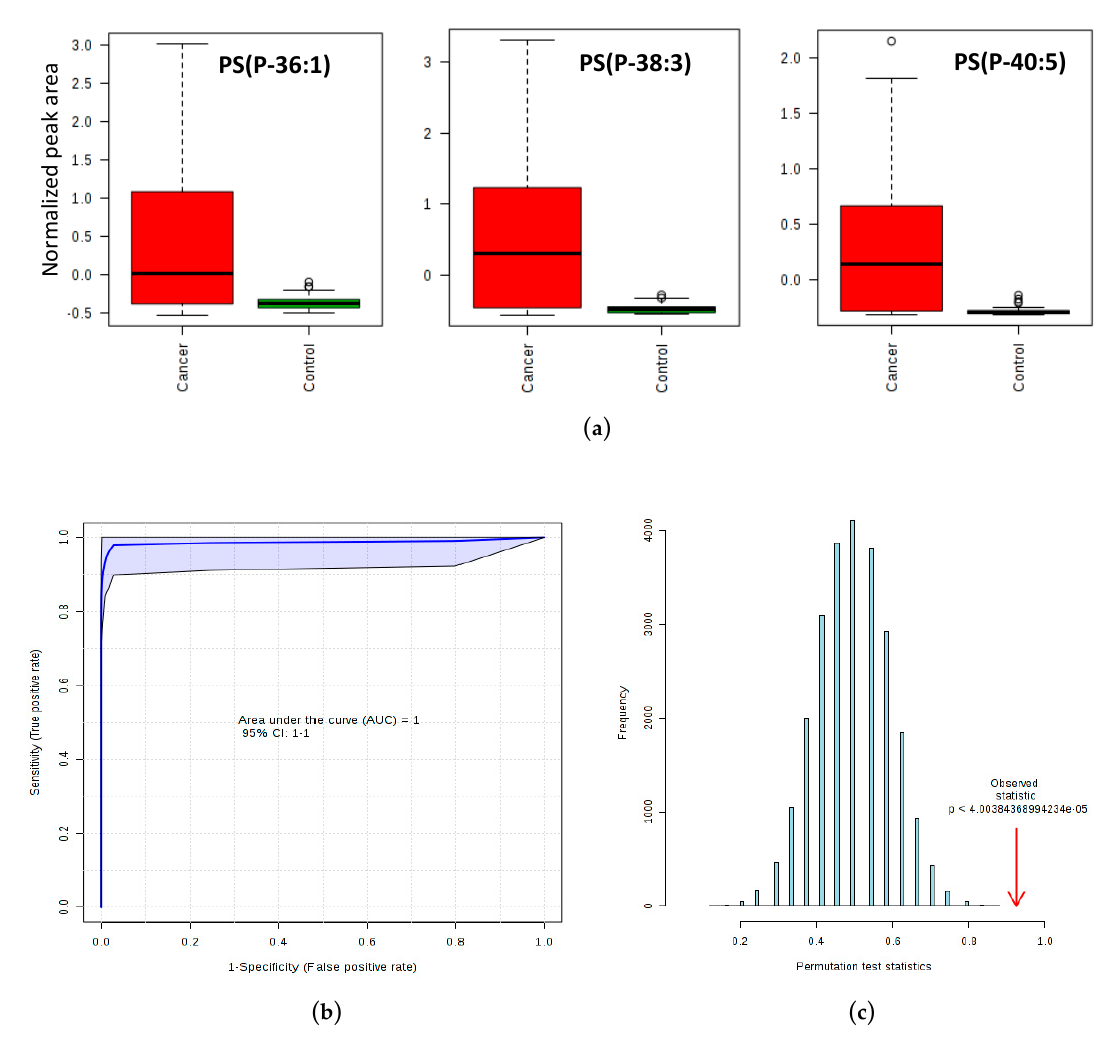
Figure 3. Plasmalogens elected for the predictive support vector machine (SVM) model. ( a ) Boxplots of the phosphatidylserine plasmalogens PS (P-36:1), PS (P-38:3) and PS (P-40:5). Data are represented as box plots with the median and 25th and 75th percentiles; error bars indicated the lowest and highest values. Open circles above and below the whiskers indicate outliers outside the 10th and 90th percentiles. ( b ) Receiver operating characteristic (ROC) curve (and 95% confidence interval) exhibiting an area under the curve (AUC) of 0.998 for the plasmalogens predictive model. ( c ) Permutation test result for the SVM model ( p < 0.05).